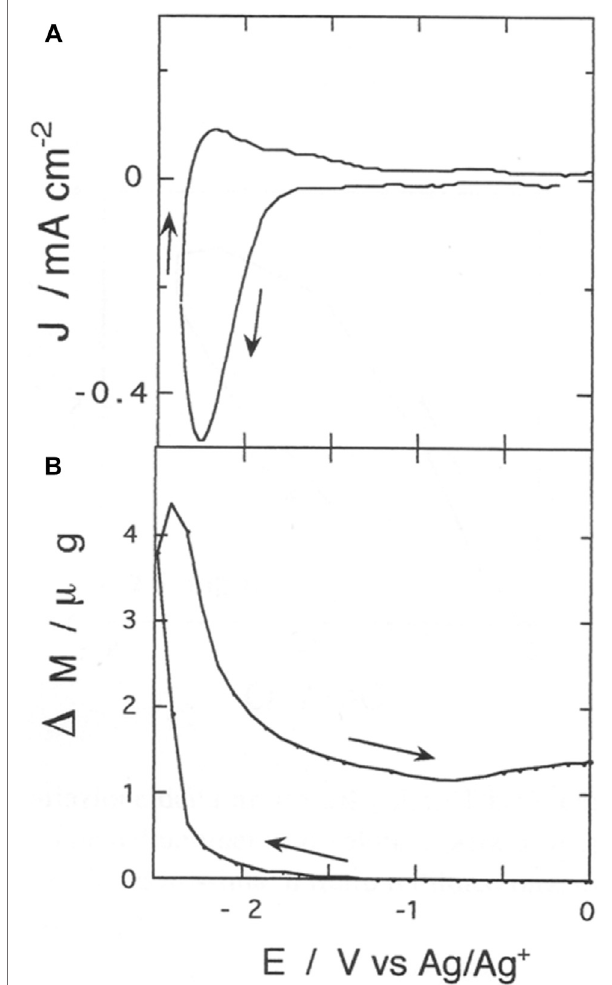
FIGURE 7 | (A) Cathodic cyclic voltammetry of poly-3,3 ″ -DDTT (scan rate: 100 mV s − 1 ); (B) electrode mass changes recorded simultaneously in situ with EQCM during cyclic voltammetry (A) . Voltammogram (A) presents features of irreversibility, while the mass curve (B) shows phenomena of mass retention within the polymer at the completion of the applied potential